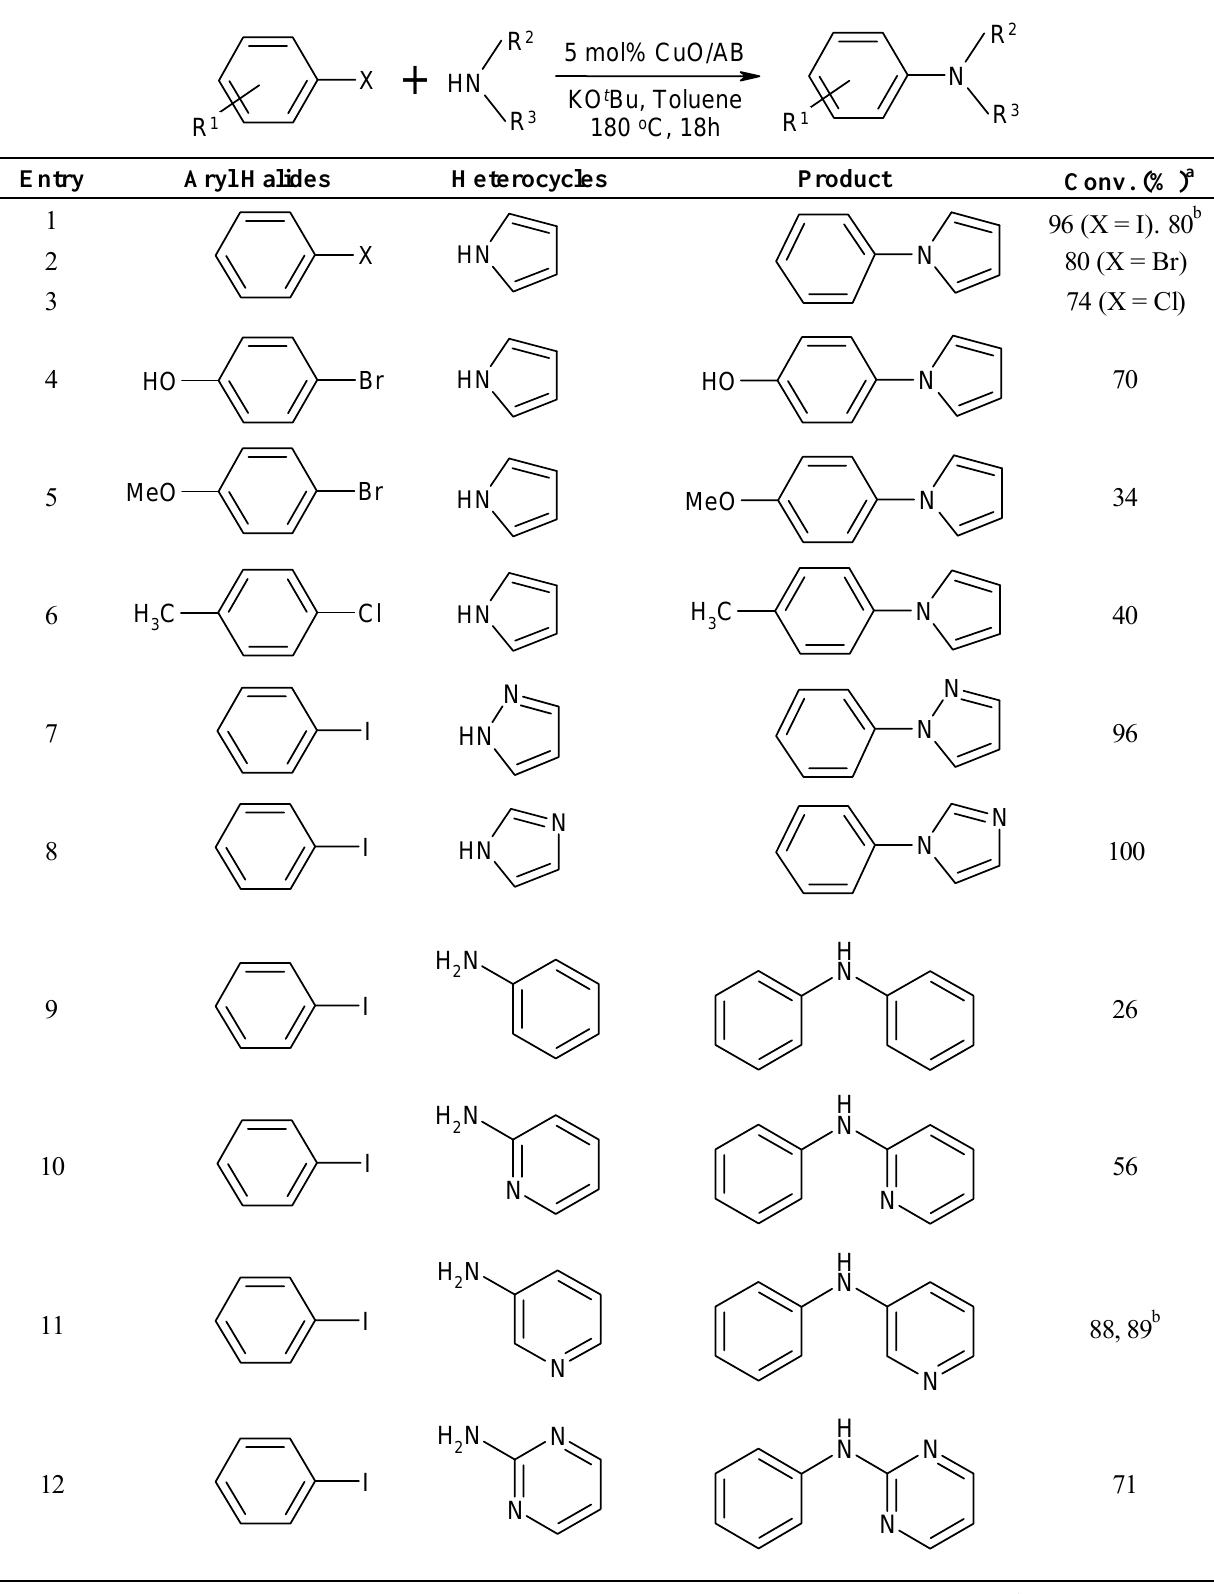
Table 2. CuO/AB catalyzed N -arylation of various Nitrogen-containing Heterocycles with Aryl